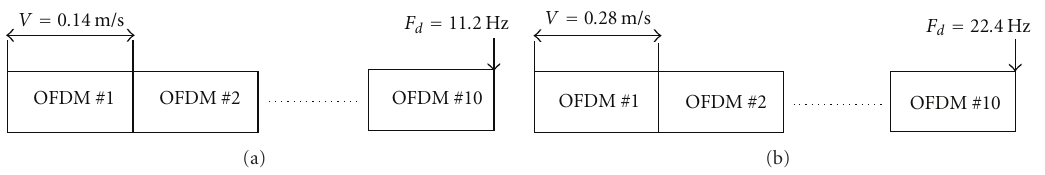
Figure 3: Acceleration e ff ect over Doppler frequency change during each symbol time at f c = 12 kHz. (a) Acc = 0 . 5m / s 2 , (b) Acc = 1m / s 2 .